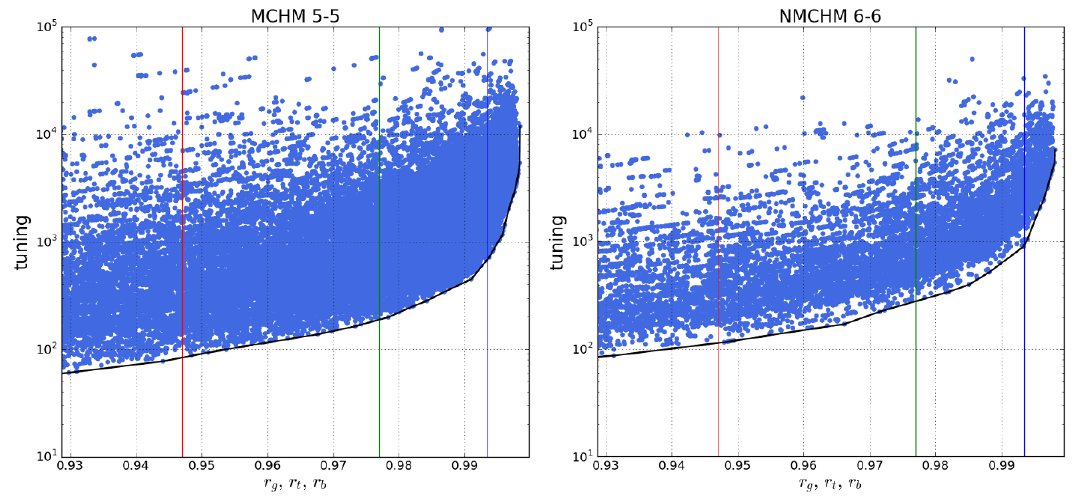
Figure 3. Comparison of higher-order tuning (de(cid:12)ned in equation (4.6)) in the Higgs-gluon, -top and -bottom coupling deviation (as de(cid:12)ned in equation (3.4)) between the minimal and next-to- minimal models. Precision bounds (denoted by coloured lines) are de(cid:12)ned in table 1. The red line shows the expected precision of a 250 GeV ILC, green a 500 GeV ILC, and blue a high-luminosity 1 TeV